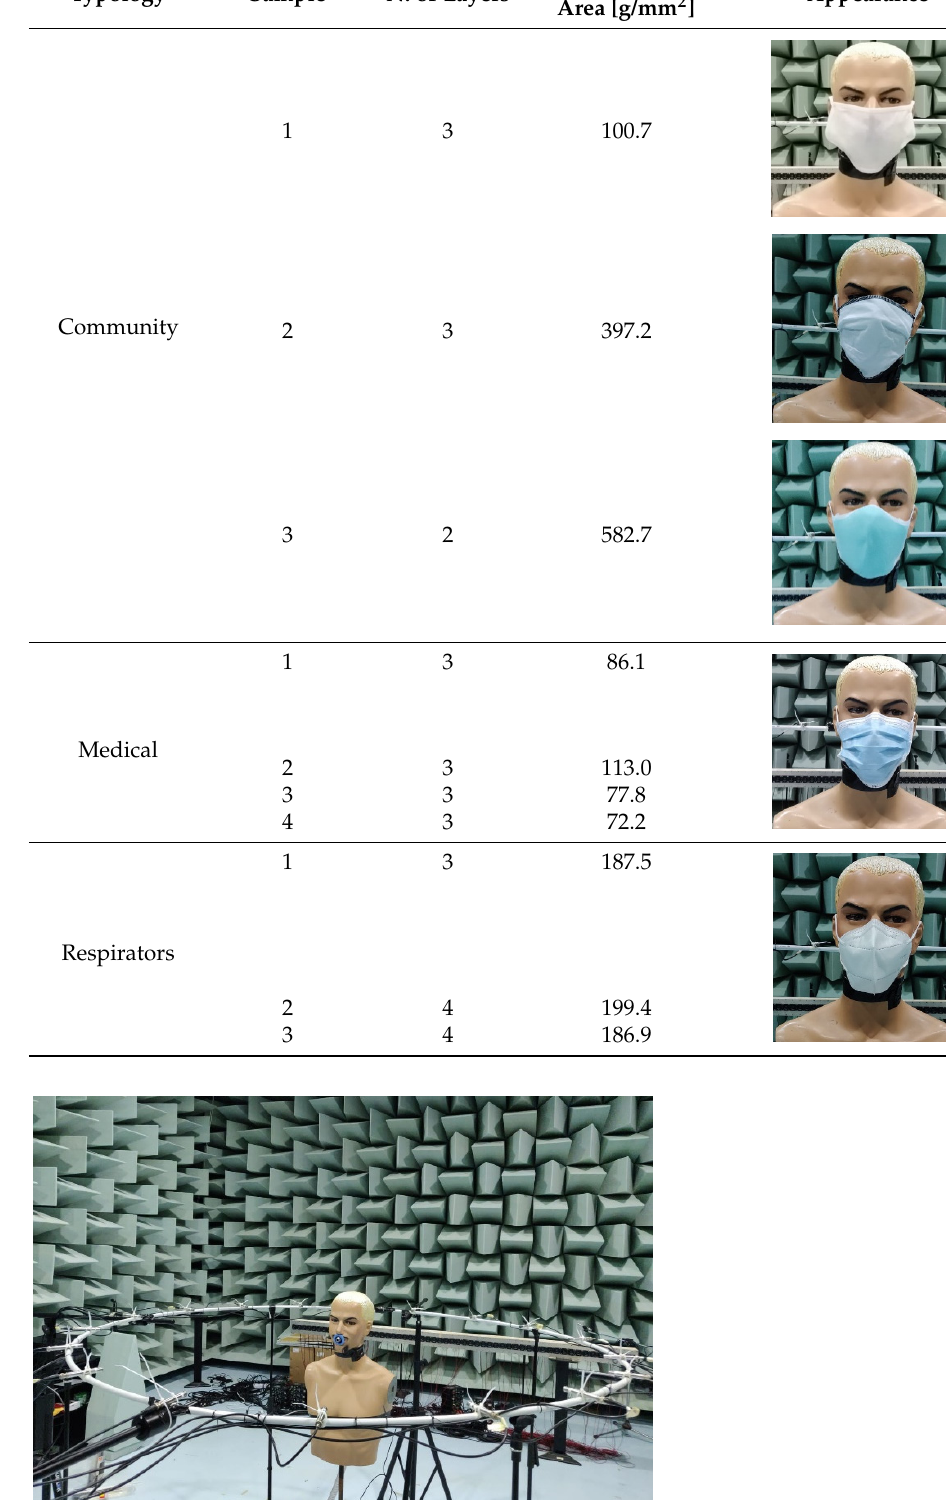
Simulator with no mask